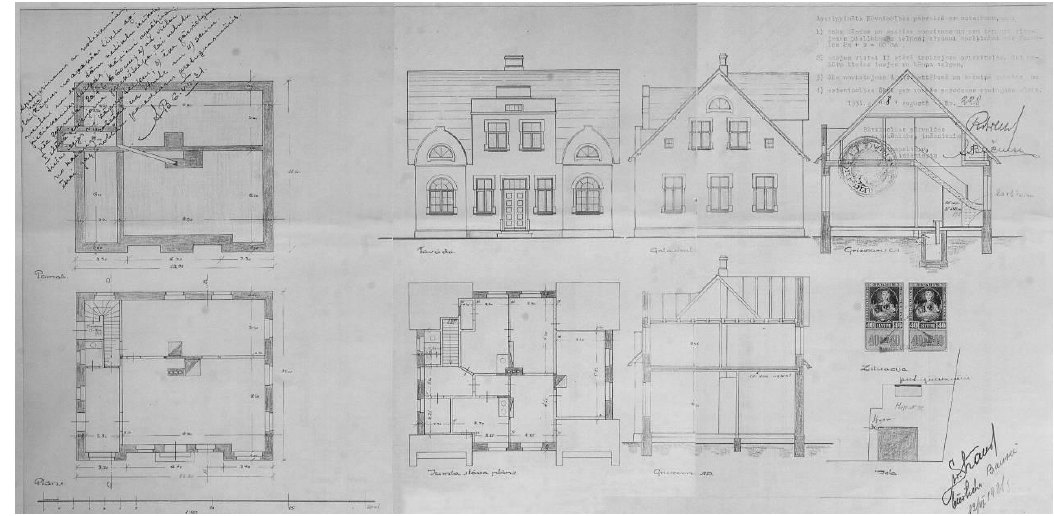
Figure 18. Design for the Hasidic Kloyz in Bauska by an unknown architect, 1931. LNA LVVA. Used by permission.